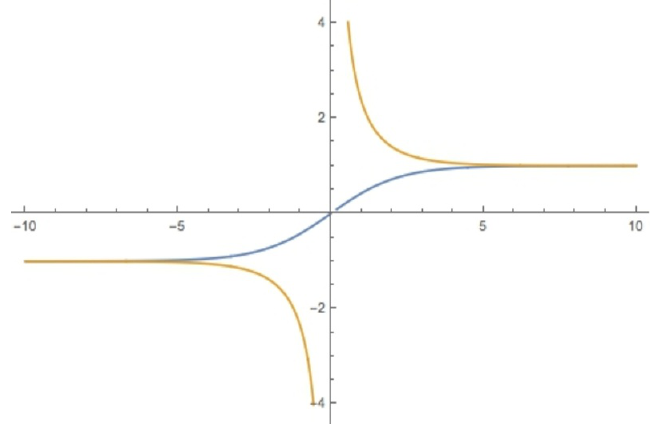
Figure 3 . Plot of the RG (cid:13)ow of ^ (cid:21)=(cid:16) s vs ln (cid:15)=(cid:15) ? where ^ (cid:21) = ( (cid:21)= 2 (cid:25)(cid:15) ) + 1 and with d ( d (cid:0) 4) = 4 < (cid:11) < ( d (cid:0) 2) 2 = 4 chosen so that (cid:16) s is real. A representative of each of the two RG-invariant classes of (cid:13)ows is shown, and (cid:15) ? is chosen as the place where ^ (cid:21) = 0 or ^ (cid:21) ! 1 , depending on which class of (cid:13)ows is of